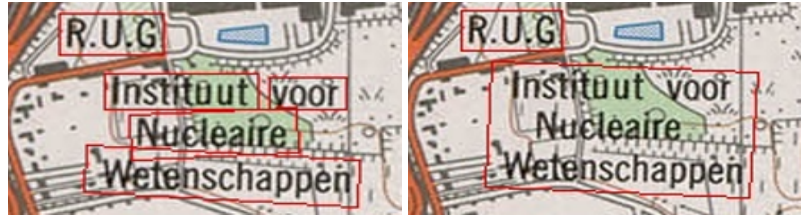
Figure 3. Example of merging the text labels in the natural reading direction.